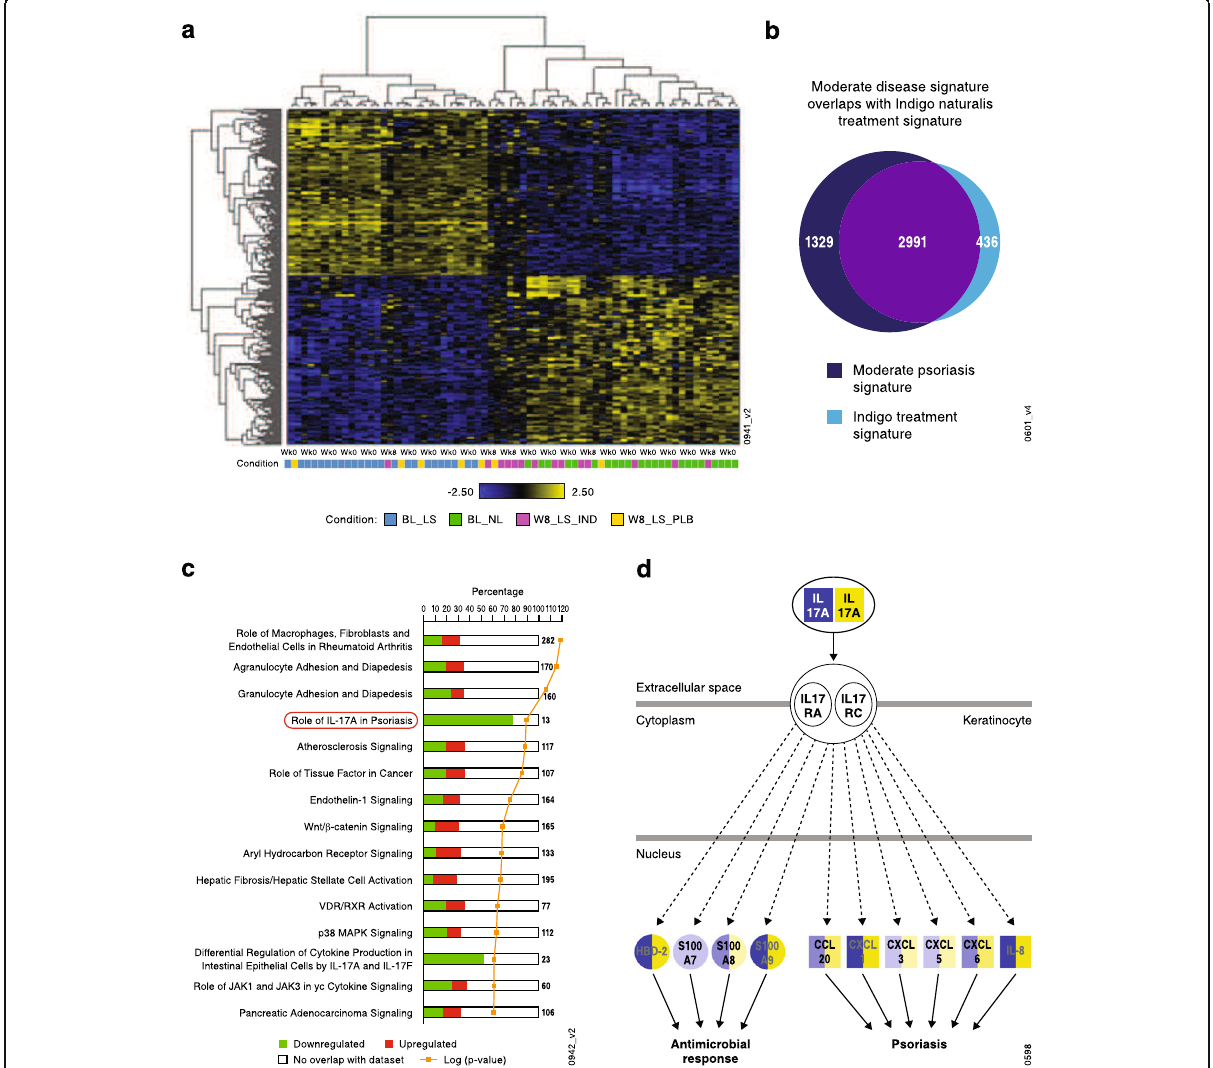
Fig. 4 Indigo naturalis treatment signature. ( a ) Hierarchical clustering diagram of baseline and post- Indigo naturalis treatment (week 8) samples of the entire study cohort; genes are represented as rows and samples as columns. Upregulated genes are shown in yellow and downregulated in blue . Samples from four different groups are denoted as follows: baseline lesional (BL_LS; blue ), baseline nonlesional (BL_NL; green ), week-8 Indigo naturalis -treated lesional (W8_LS_IND; purple ), and week-8 placebo-treated (W8_LS_PLB; yellow ); ( b ) a Venn diagram comparing moderate psoriasis gene signature ( dark blue circle on the left) and Indigo naturalis treatment signature ( light blue circle on the right); ( c ) enrichment of Ingenuity pathways by Indigo naturalis treatment gene signature. The stacked bar chart displays the number of up-regulated ( red ) and down-regulated ( green ) in each Ingenuity Canonical Pathway. The pathways are ranked by the p -value of a Fisher exact test from top to bottom (orange line; p - value listed in Additional file 3); ( d ) the “ Role of IL-17A in psoriasis ” pathway overlaid with the gene expression pattern and each circle represents one gene. Differential expression between lesional and nonlesional sample at baseline is shown in left-half of each circle, and differential expression between week 8 and baseline samples is shown in right- half of circles. Yellow = up-regulated, blue = down-regulated, IL = interleukin, RA, receptor A, RC, receptor